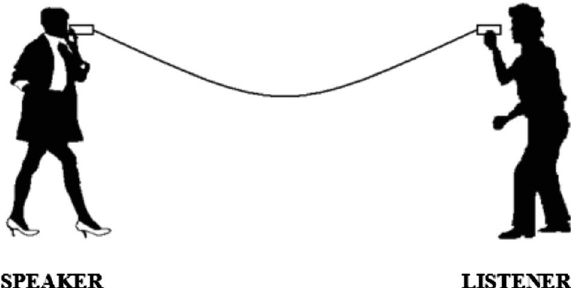
FIG. 10. Picture available to students for better understanding of the situation and for optional drawing during discussion related to context 5 in interview protocol.